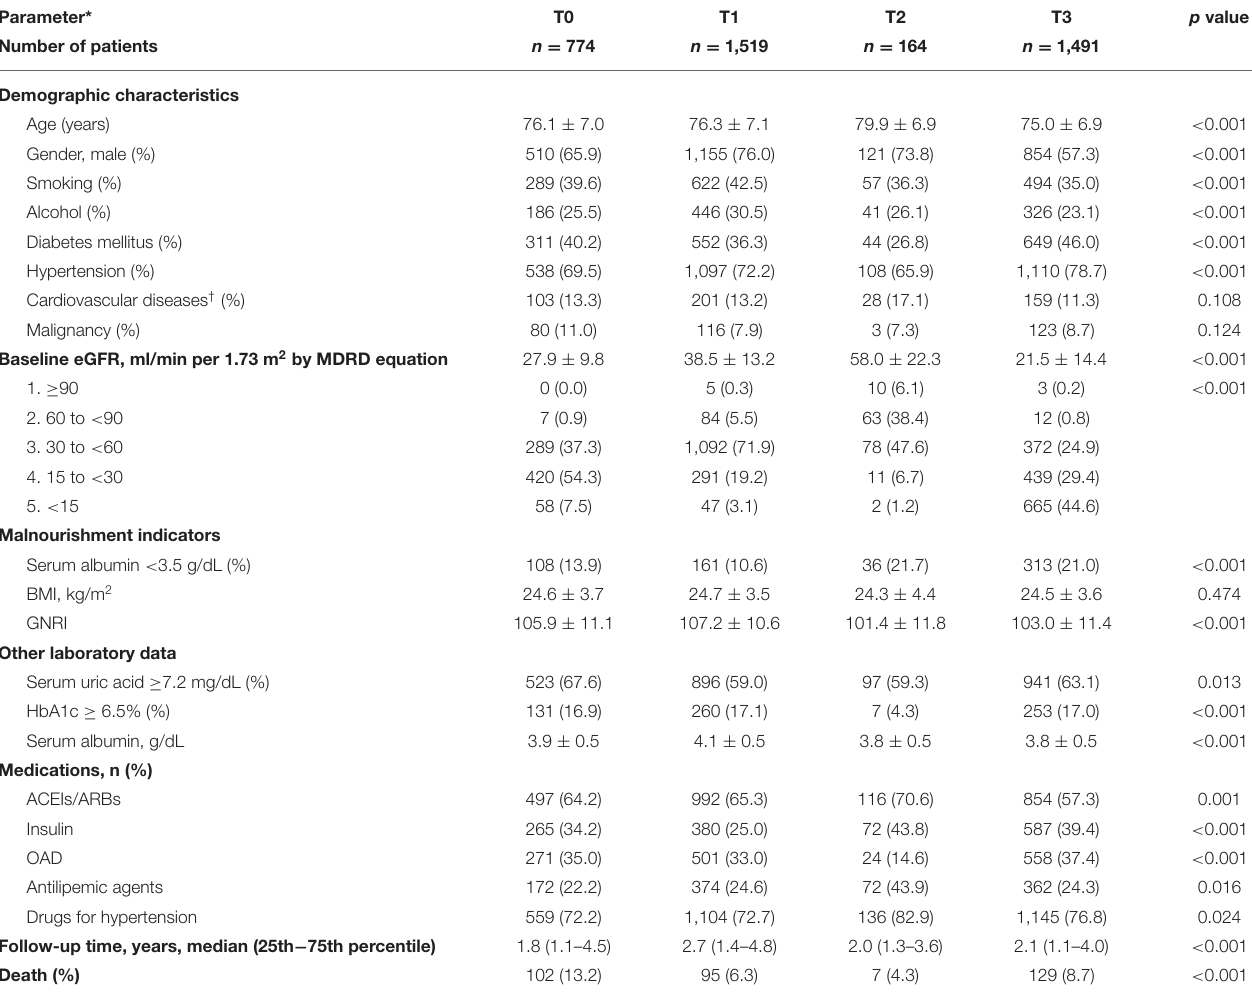
TABLE 1 | Demographic and clinical characteristics of four eGFR